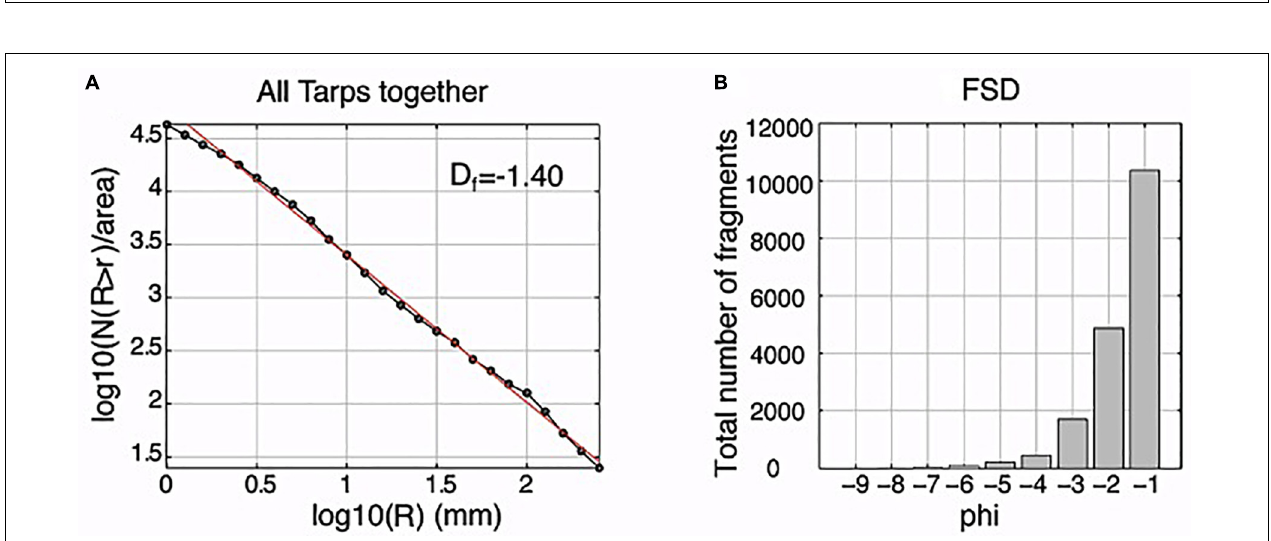
FIGURE 4 | (A) Fragment distributions and (B) total fragment size distribution for all three tarps (see Supplement for full data set including those for the bins whose values are too low to be seen on this style of plot).